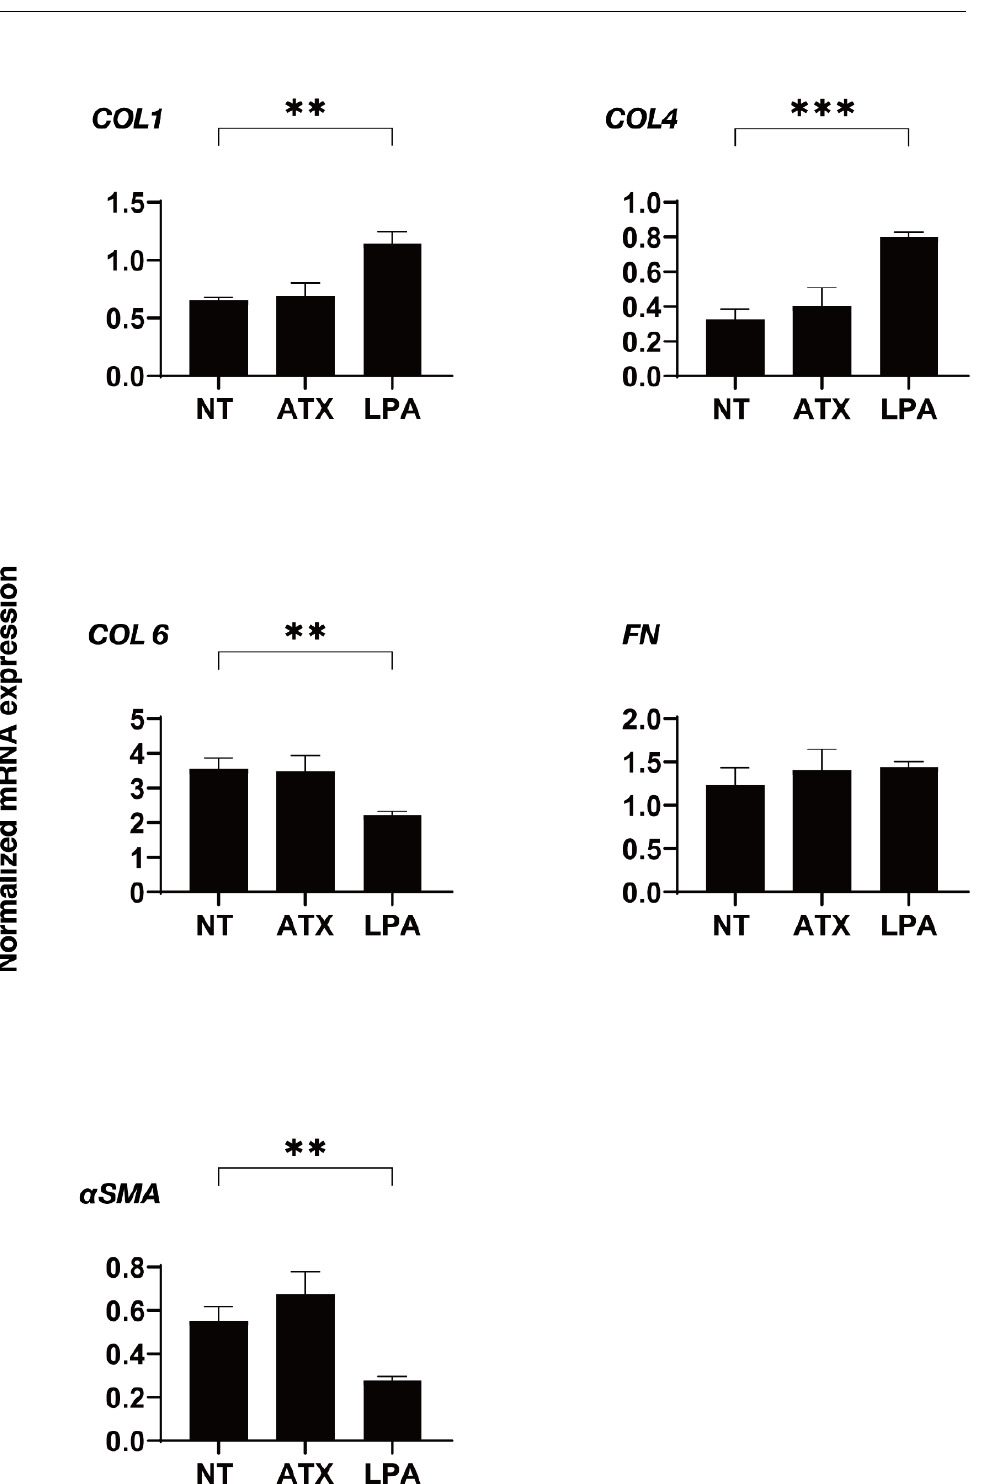
Figure 4. mRNA expression of ECM molecules in 3D cultured HTM cells. During the 6-day culture of the 3D HTM spheroids, 2 mg/L ATX or 200 nM LPA was exposed during Day 5 through 6, and the mRNA expression of ECMs ( COL1 , COL4 , COL6 , FN and α SMA ) were measured. All experiments were performed in duplicate using fresh preparations. NT; untreated control. Data are presented as the arithmetic mean ± standard error of the mean (SEM). ** p < 0.01, *** p < 0.005 (ANOVA followed by Tukey’s multiple comparison test).